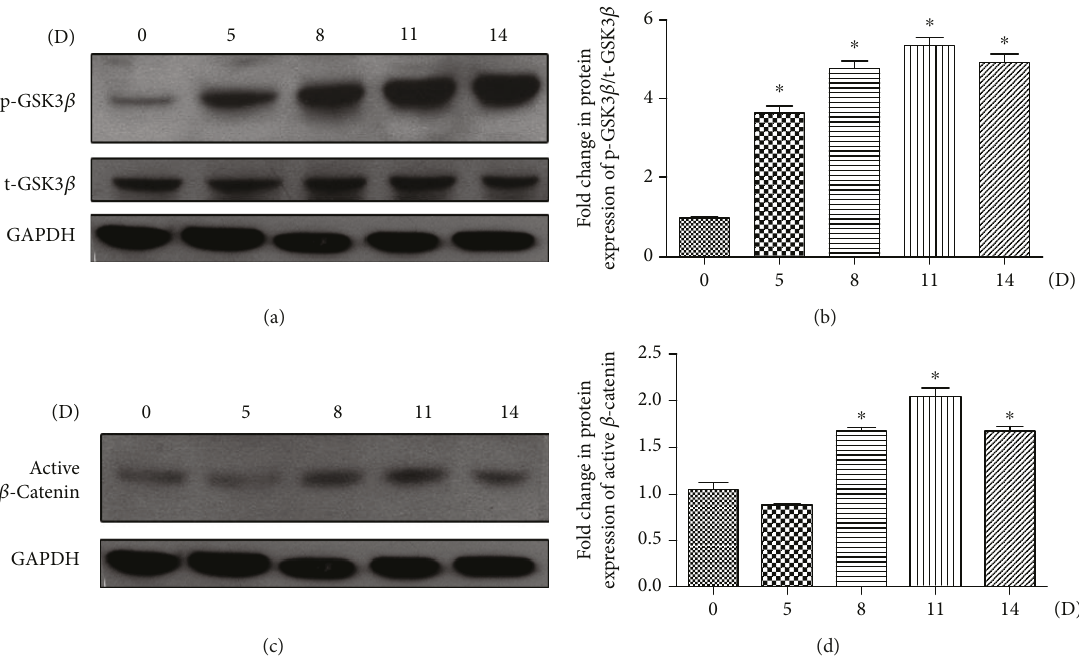
Figure 3: The involvement of Wnt-mediated GSK3 β / β -catenin in SMC di ff erentiation from DPSC clone A32. The A32 clone was induced according to the SMC induction protocol, 20% conditioned medium, and 2.5ng/mL TGF- β 1 for the indicated time (0 d, 5d, 8 d, 11d, and 14d). The protein levels of p-GSK3 β , t-GSK3 β , and β -catenin were analysed with western blotting (a and c). The relative band intensities were determined by densitometry (b and d). Statistical analysis was performed by using one-way ANOVA. Date are shown as means ± SEM . ∗ P < 0 05 when compared with the 0 d